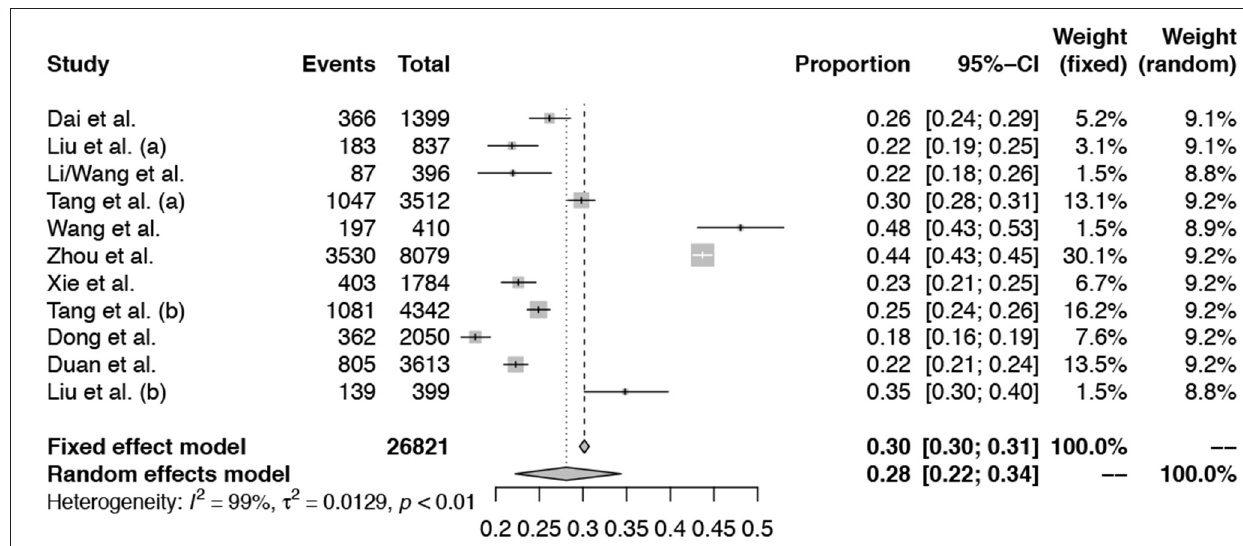
FIGURE 2 | Forest plots of the meta-analysis for the pooled prevalence of the mental